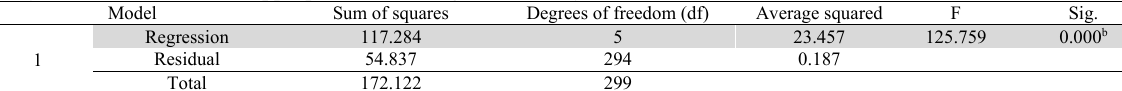
Analysis of ANOVA on the appropriateness of regression analysis Model Sum of squares Degrees of freedom (df) Average squared F